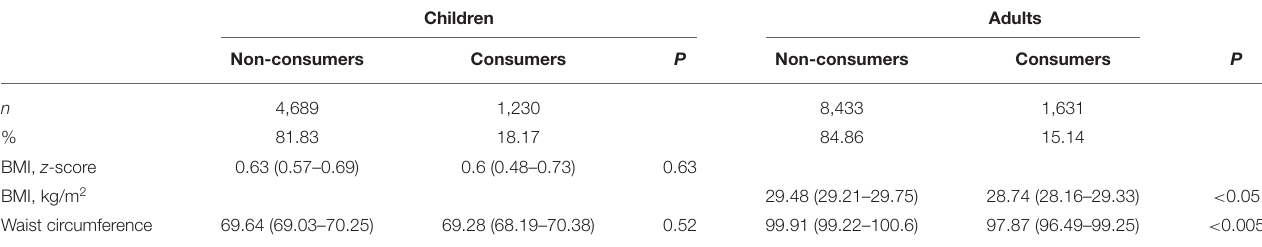
TABLE 5 | Comparison of adjusted averages of anthropometric measures between consumers and non-consumers of OJ among children and adults,